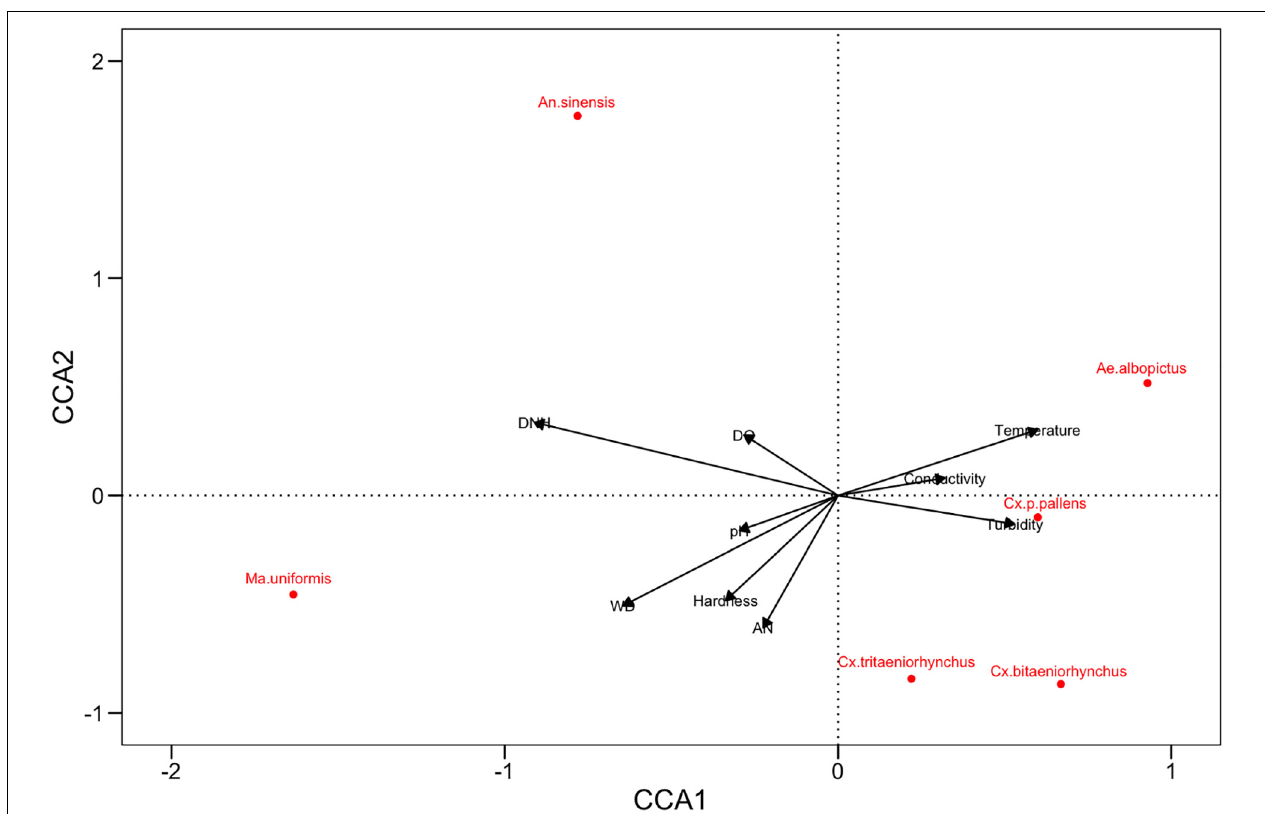
FIGURE 5 | Biplot representing the results of CCA, the relationship between the larval density (red labels) and the physicochemical variables (black arrows). The constrained inertia explained by the CCA is 31.18%, and the proportion explained by CCA1 axis and CCA2 axis was 35.35% and 10.27%,